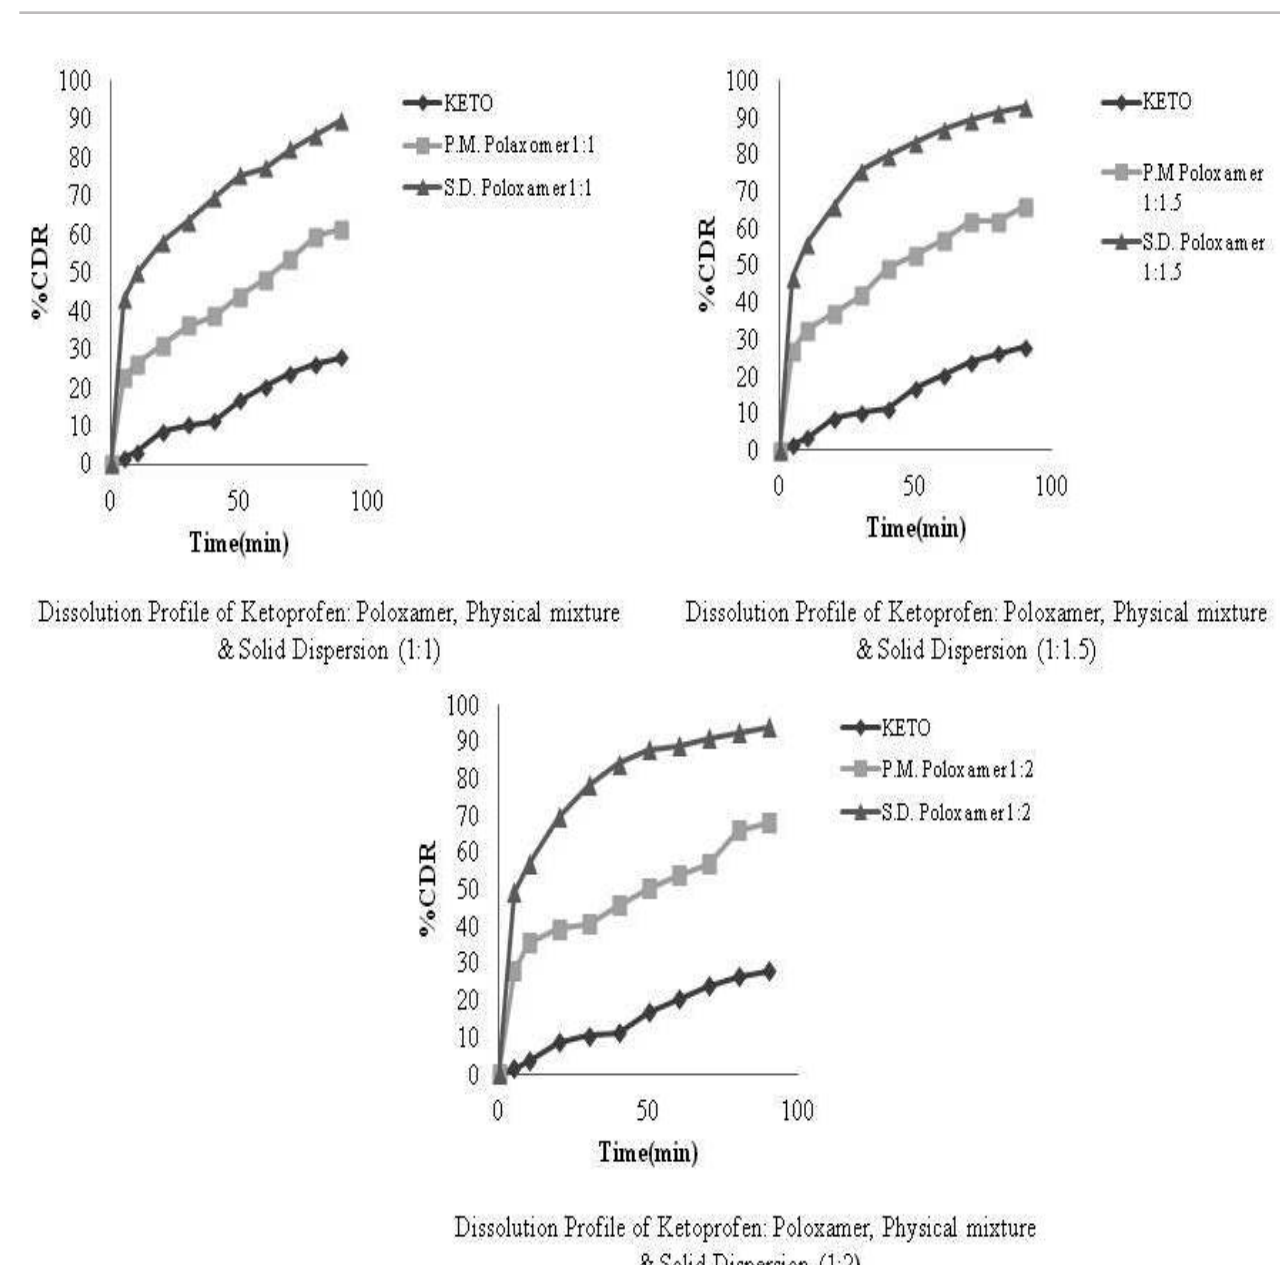
FIGURE 7 - Dissolution profile of Ketoprofen, physical mixture and solid dispersion with Polaxamer